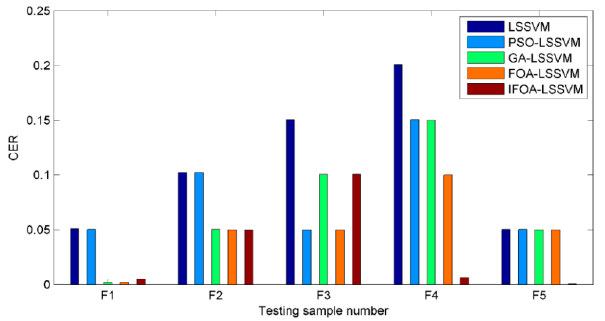
Figure 10. The CER s of five cutting types based on different models.